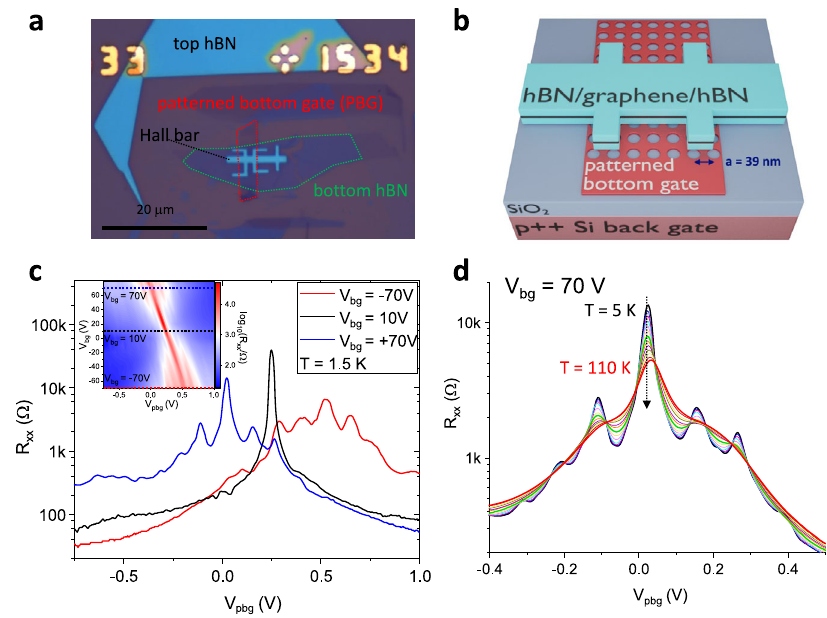
Fig. 2 Sample layout and basic transport characterisation. a Optical micrograph of the sample after van der Waals stacking and mesa etching. b Schematic view of the sample design showing the patterned bottom gate underneath the hBN encapsulated graphene sheet. c Longitudinal resistance R xx as a function of V pbg at three different back gate voltages V bg at T = 1.5 K. By increasing the modulation strength ( V bg = ± 70 V), satellite Dirac peaks start to occur. The inset shows the overall gate map of the system, R xx as a function of V pbg and V bg . d Longitudinal resistance R xx as a function of V pbg at V = 70 V for different temperatures ranging from T = 5 K to T = 110 K. By increasing the temperature, superlattice induced satellite Dirac peaks start to bg vanish.